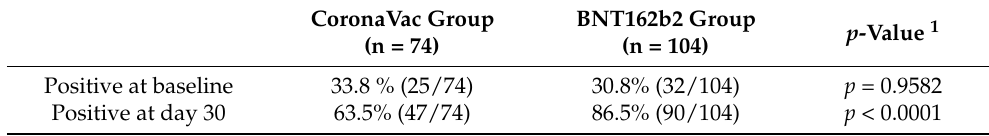
Table 4. QuantiFERON-SARS-CoV-2 positivity before and after CoronaVac and BNT162b2 booster.